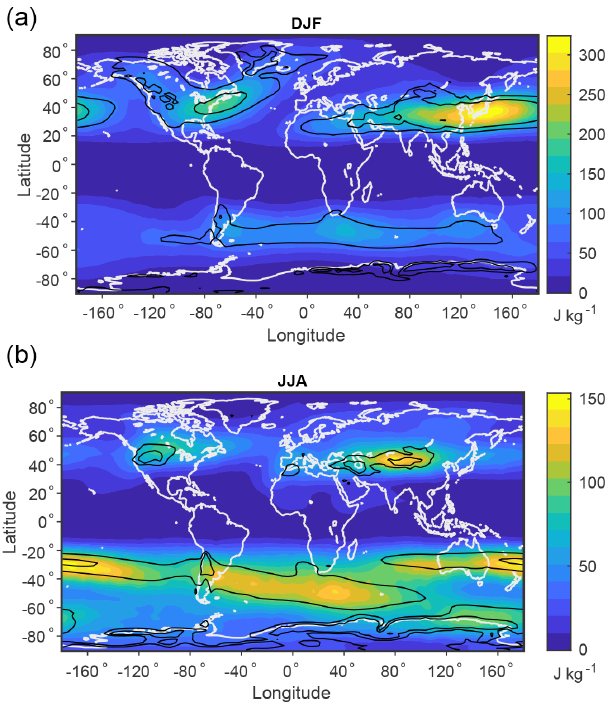
Figure 6. Convective local MAPE based on the climatological mean (color shading) over 1979–2018 and occurrence of intense convec- tion events (black dots) over 2015–2021 for (a) DJF and (b) JJA. Convective MAPE is calculated as the difference in MAPE and nonconvective MAPE in the local subdomains. Intense convection events are identified using GPM data as precipitation features with a maximum 40dBZ echo top height that exceeds 14km over land and 9km over ocean (see text for further